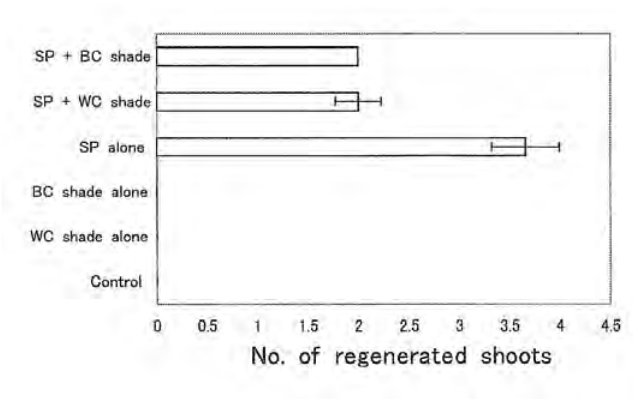
Fig. 13 - Effect of late summer pruning and shading on the number of regenerated shoots of peach trees. SP = summer pruning; WP = winter pruning, WC = white cheesecloth; BC = black cheesecloth. Data are presented as mean ± standard error ( se Table 4 - Effect of summer and winter pruning on fruit yield and quality in peach trees Fruit Treatment